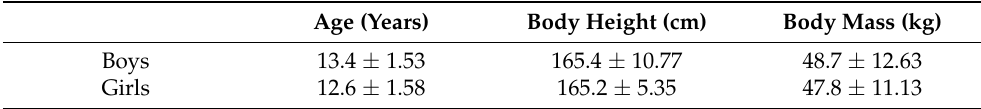
Table 1. Characteristic of study group (values are mean +/ −